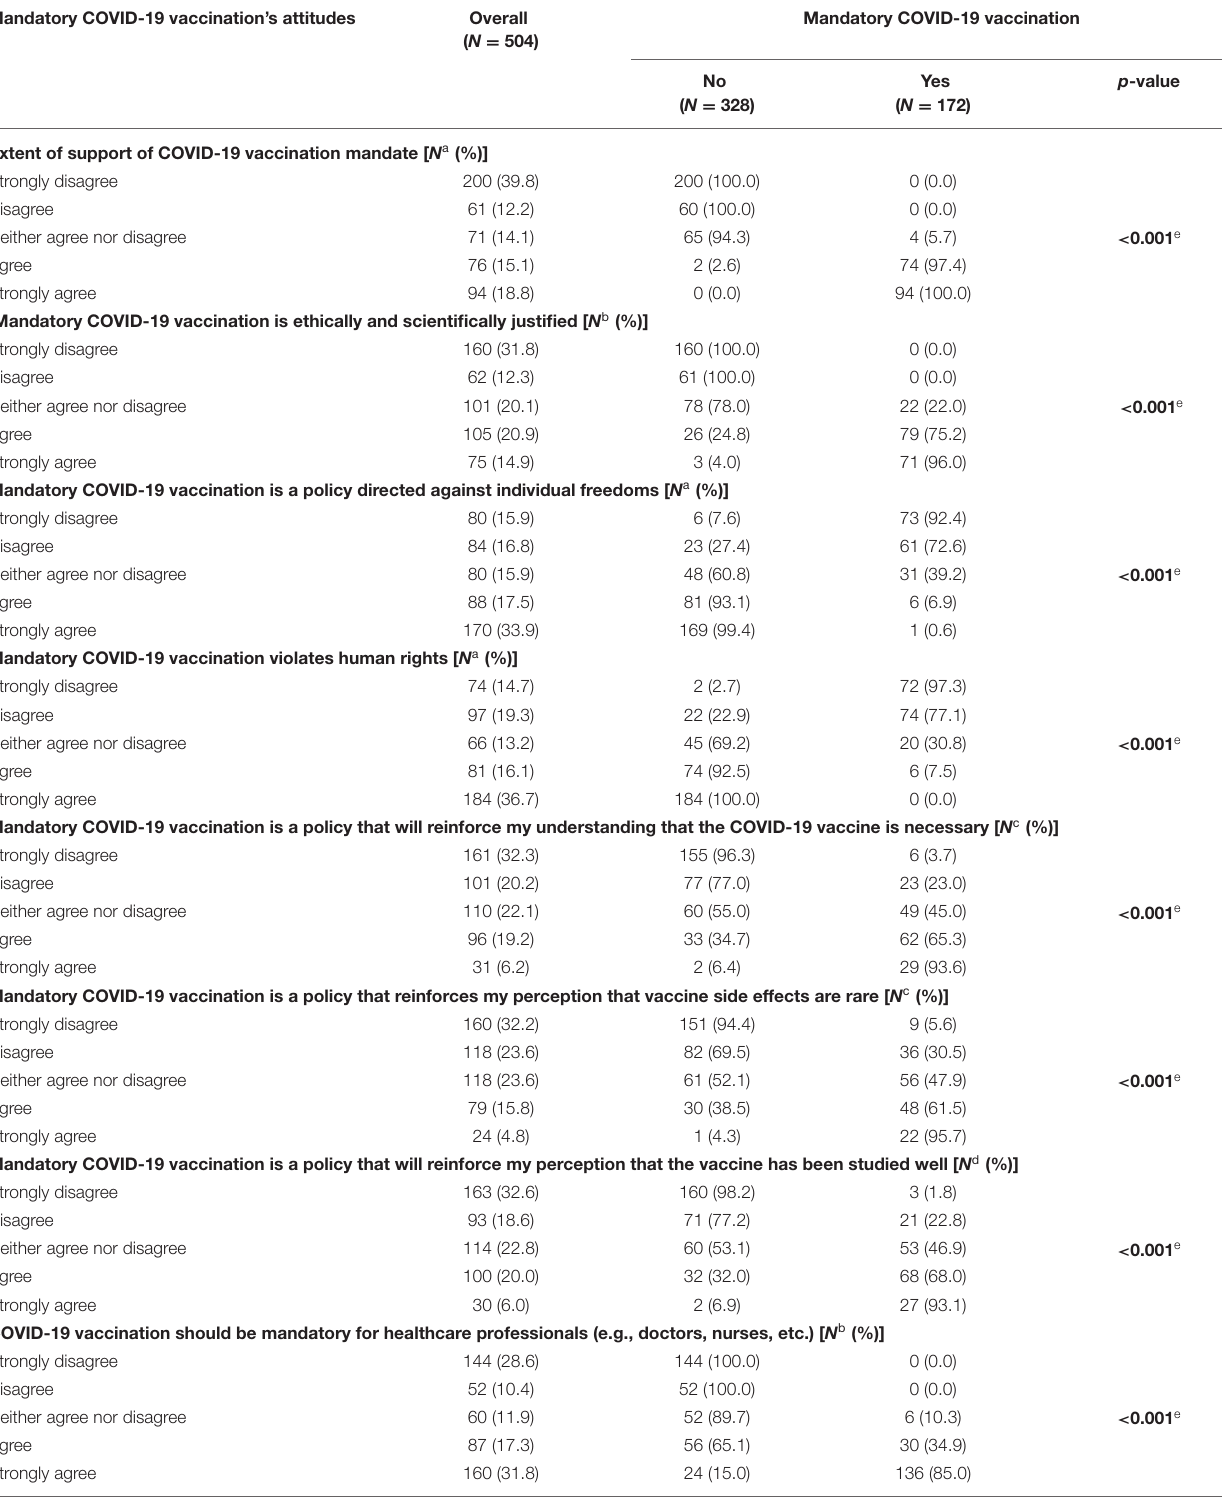
TABLE 2 | Participants’ attitudes toward mandatory COVID-19 vaccination, overall and by mandatory vaccination support. Mandatory COVID-19 vaccination’s attitudes Overall ( N =